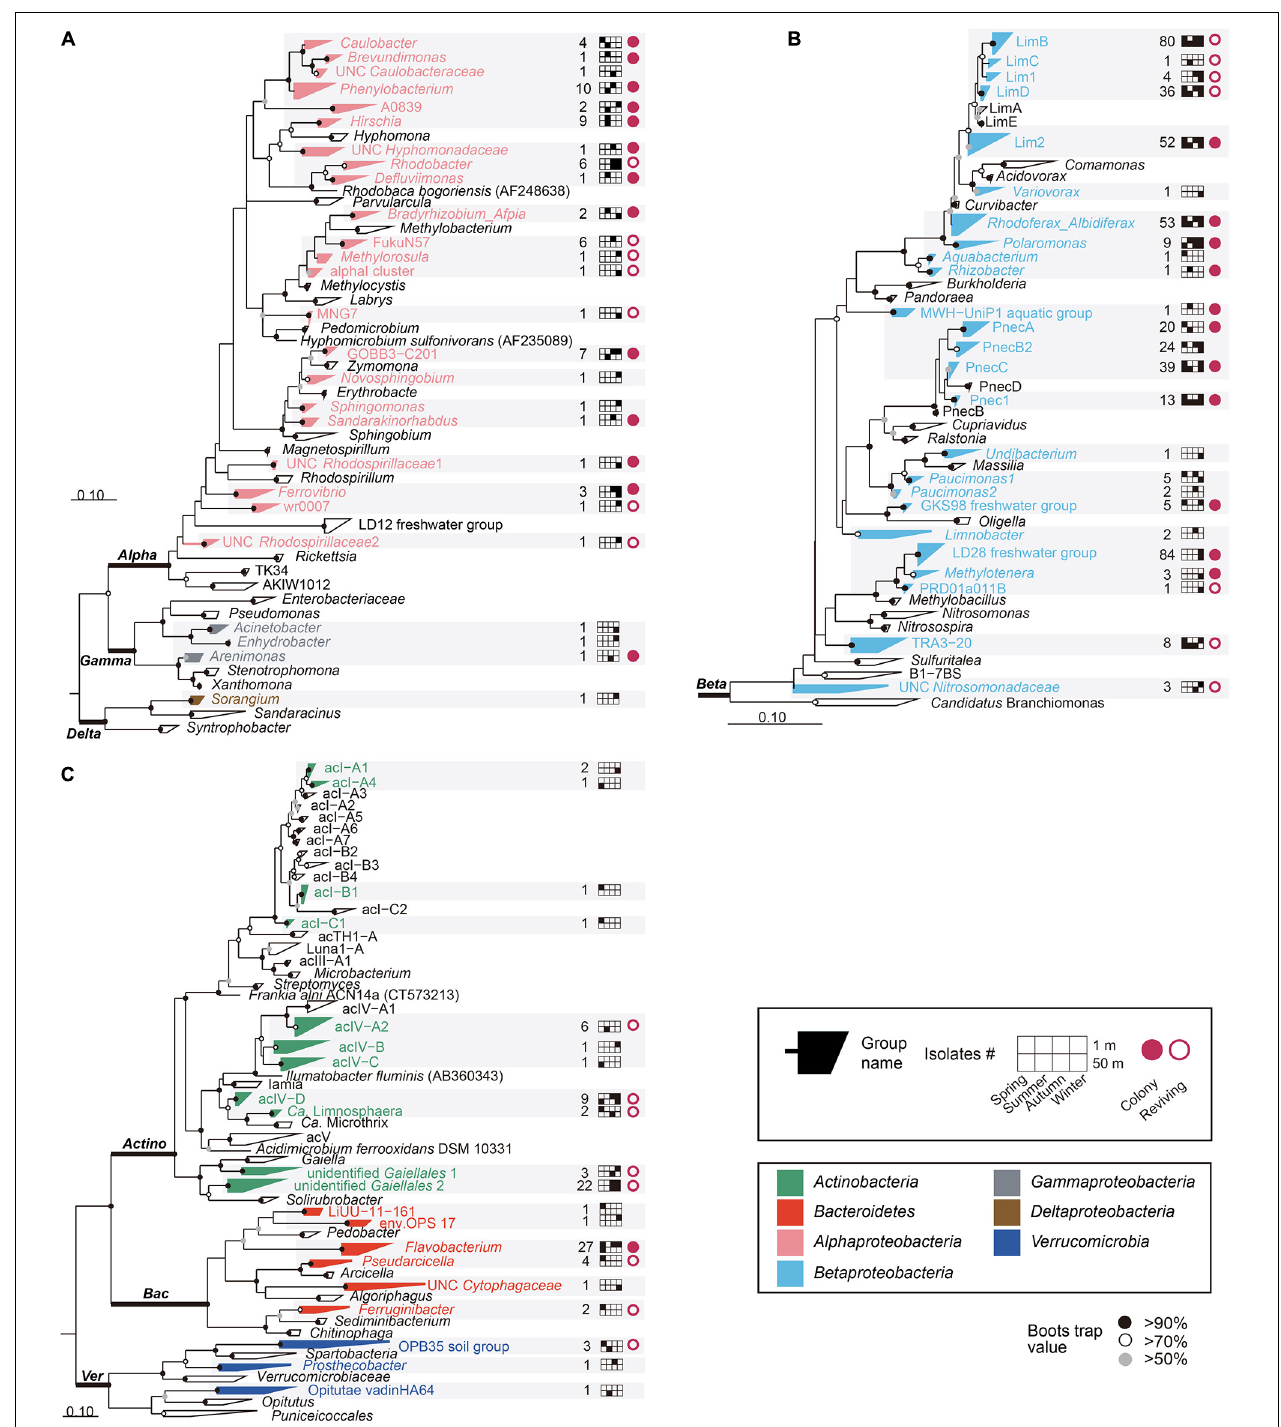
FIGURE 1 | Maximum-likelihood phylogenetic trees based on 16S rRNA gene sequences showing the positions of the cultivated isolates within (A) Alphaproteobacteria, Gammaproteobacteria , and Deltaproteobacteria ; (B) Betaproteobacteria ; (C) Actinobacteria, Bacteroidetes , and Verrucomicrobia . Bacterial/group names are listed at the end of the tree tips. The phylogenetic groups represented by the HTC strains isolated in this study are displayed in different colors depending on the different phyla/classes, along with the number of isolates, information on seasons and depths, and colony-forming and reviving capability. UNC: uncultured. Bootstrap supporting values are shown at the nodes as filled solid circles ( > 90%), empty circles ( > 70%), and gray circles ( > 50%).